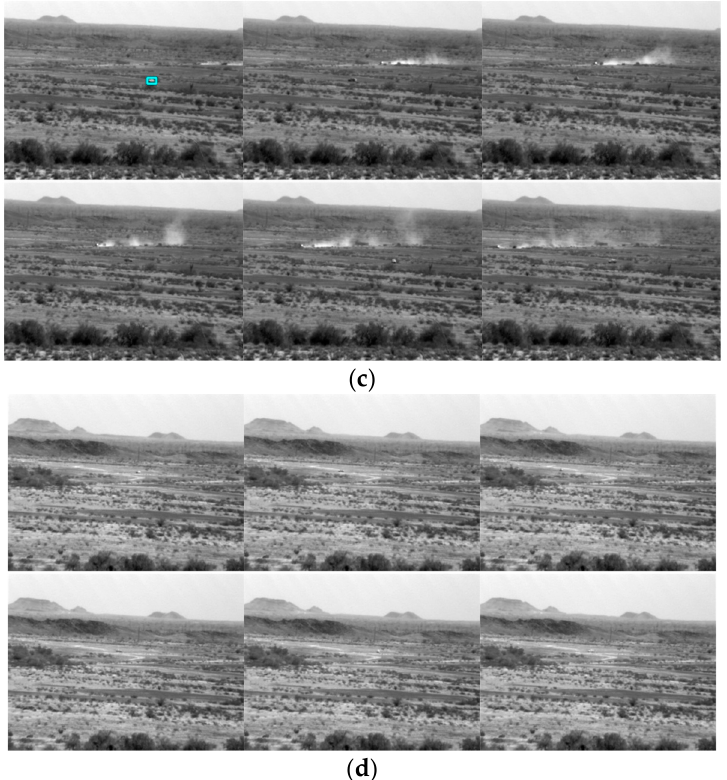
Figure 9. Tracking results for frames 1, 63, 126, 189, 252, and 315 in the PCE full (optical videos) case. The vehicle is SUV. Coded aperture compresses every five frames into one. ( a ) 1000 m; ( b ) 2000 m; ( c ) 2500 m; and ( d ) 3500 m.